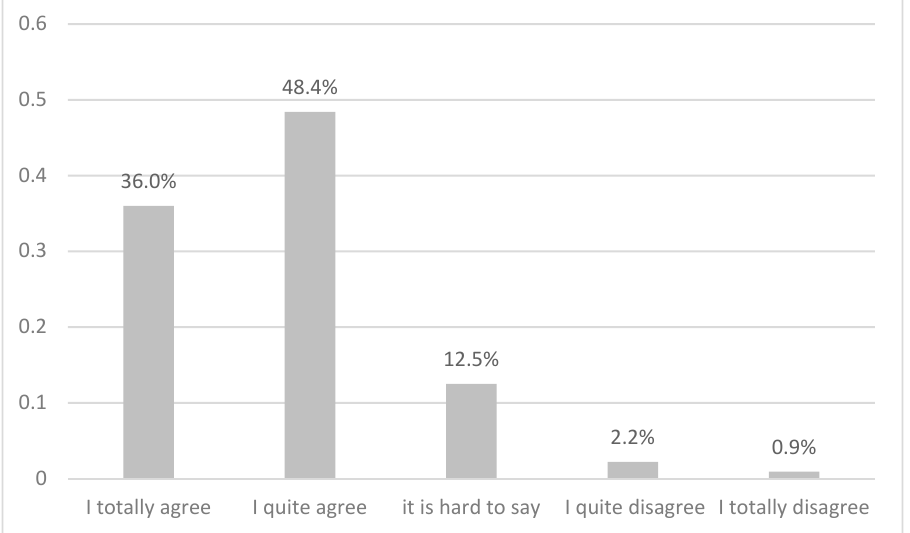
Figure 1. Survey responses to “Do you consider your everyday decisions to be guided by environment protection factors?” question. Source: own elaboration.